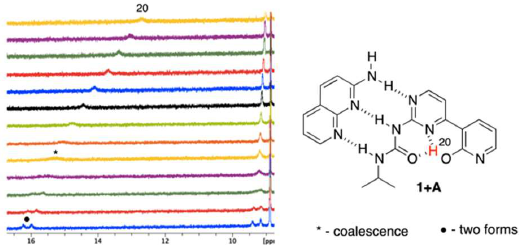
Figure 4. The VT spectra for 1 + A complex (+20 to −40 °C, from top to bottom).